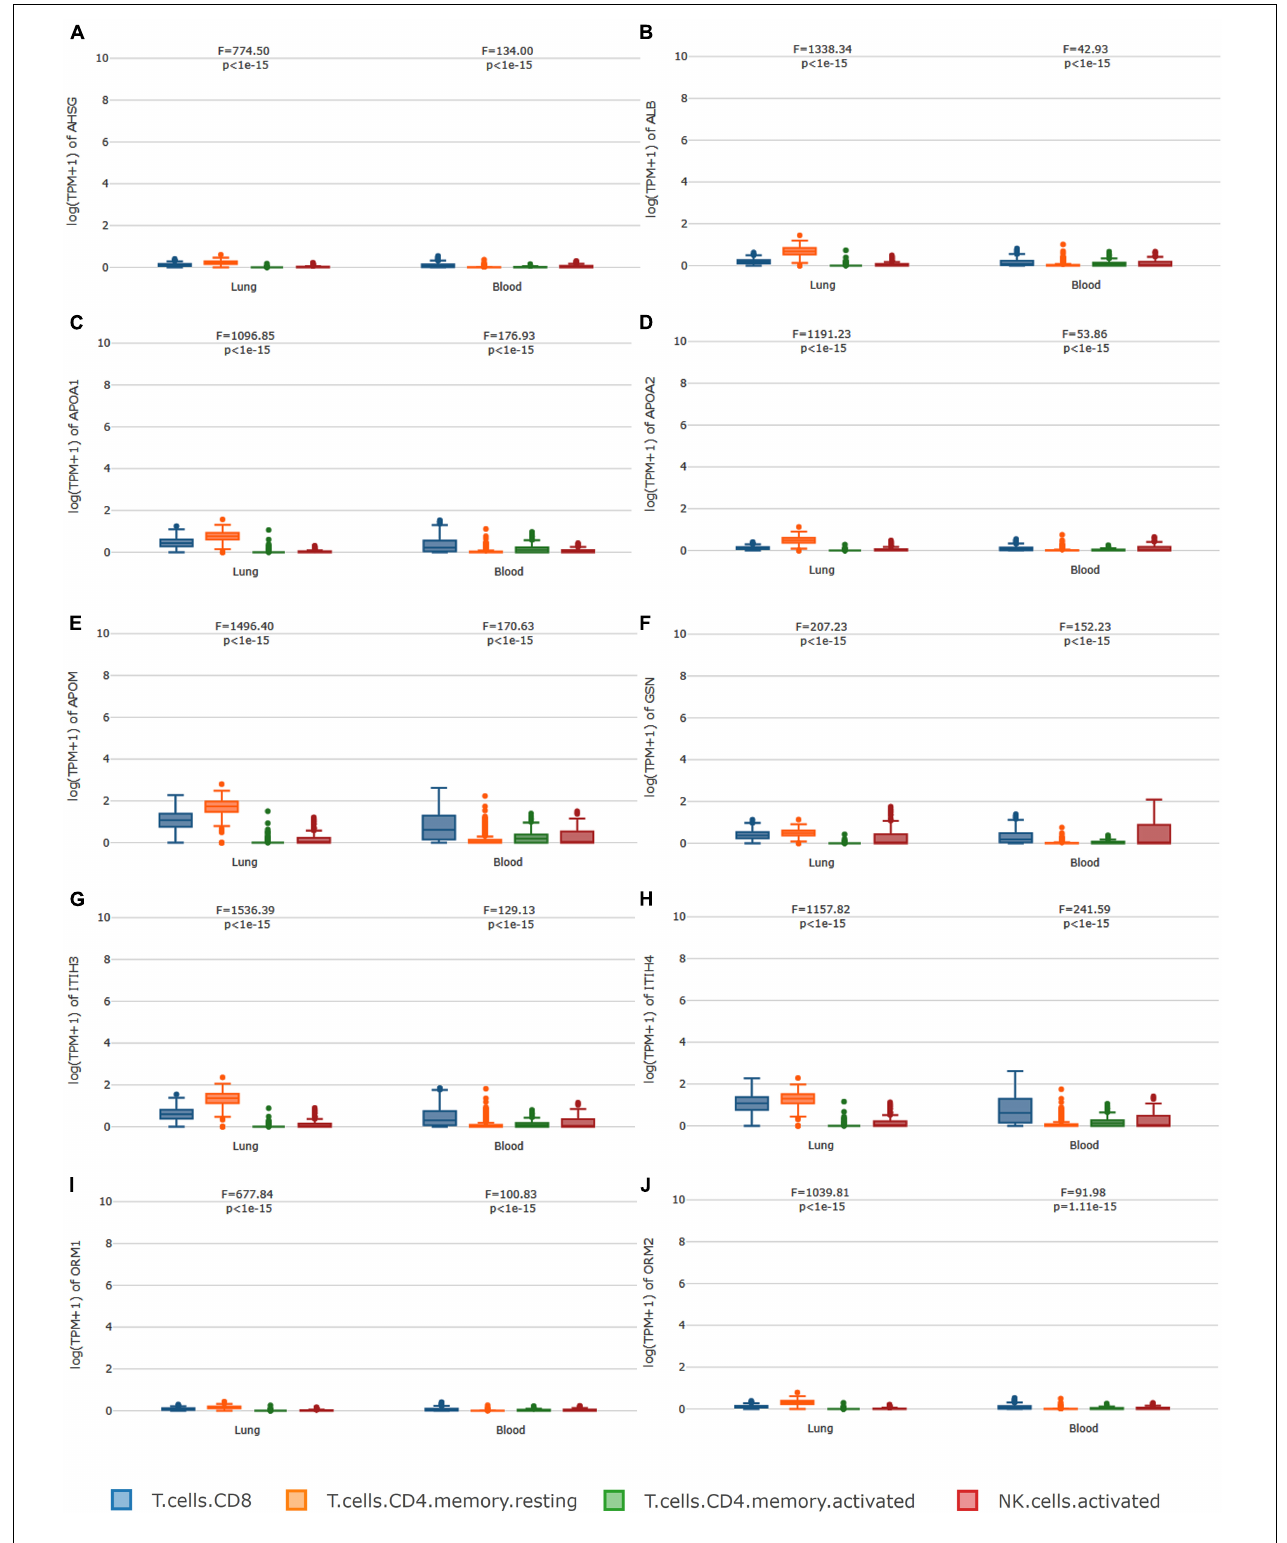
FIGURE 5 | Immune cell type-level expression analysis. In regard to (A–J) , the analysis of immune infiltration revealed that the CD4 + cell has the highest median value in the lung, and the CD8 + cell has the highest median value in blood except for GSN. A component analysis of the immune cells showed that CD4 + T cells, CD8 + T cells, and NK cells were significantly related to the 10